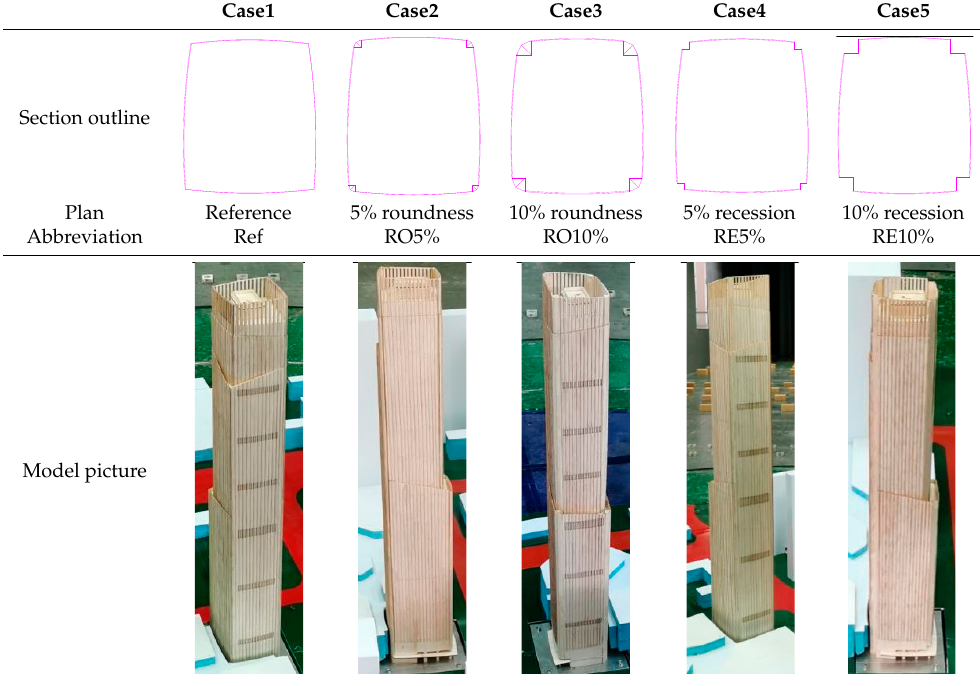
Figure 1. ( a ) Model and surroundings in the wind tunnel. ( b ) Model detail. ( c ) Wind direction. Table 2. Corner Modifications.